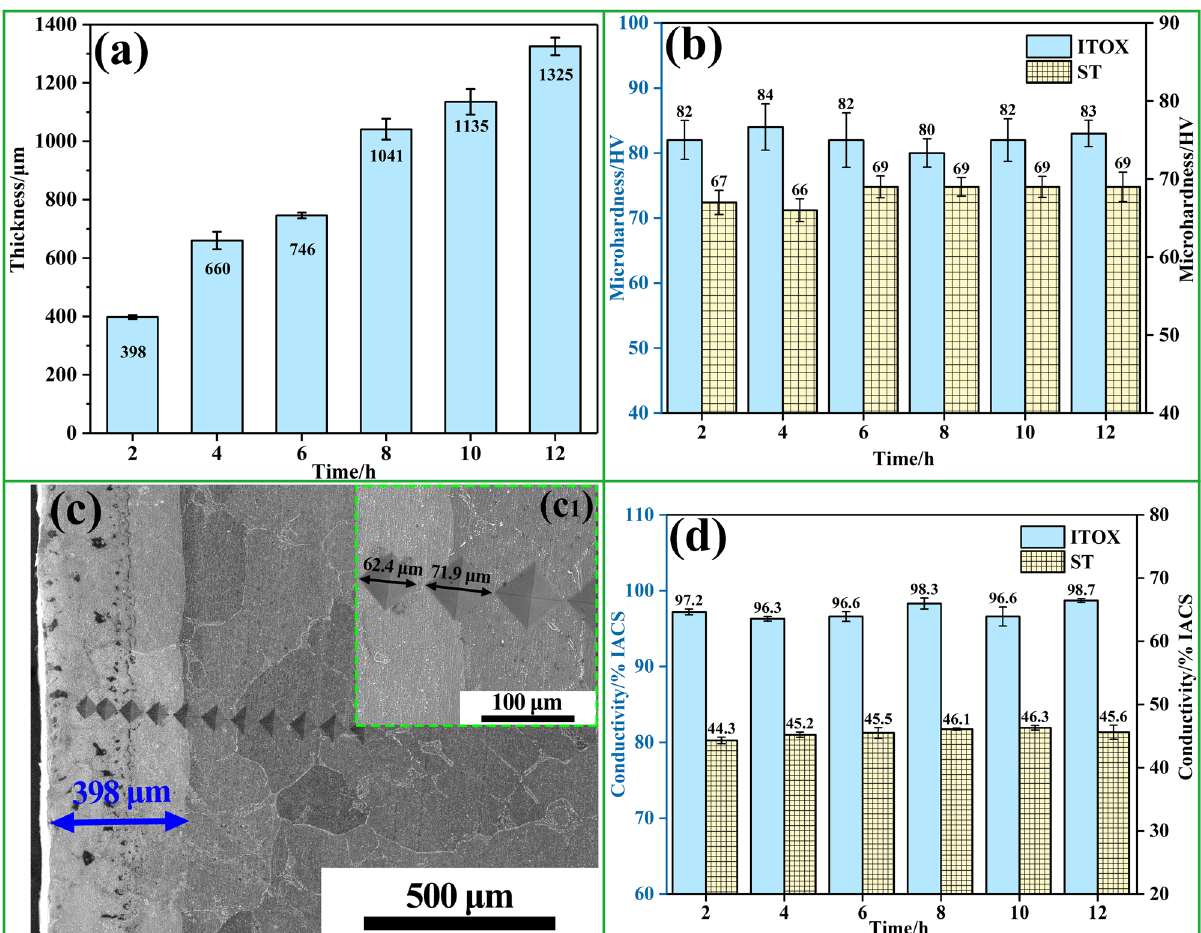
Figure 2: ( a ) E ff ect of internal oxidation time on the thickness; ( c ) microhardness indentation image of Cu – Cr – Ti alloy; ( b ) microhardness and ( d ) electrical conductivity of Cu – Cr – Ti alloy after ST and ITOX treatment for di ff erent